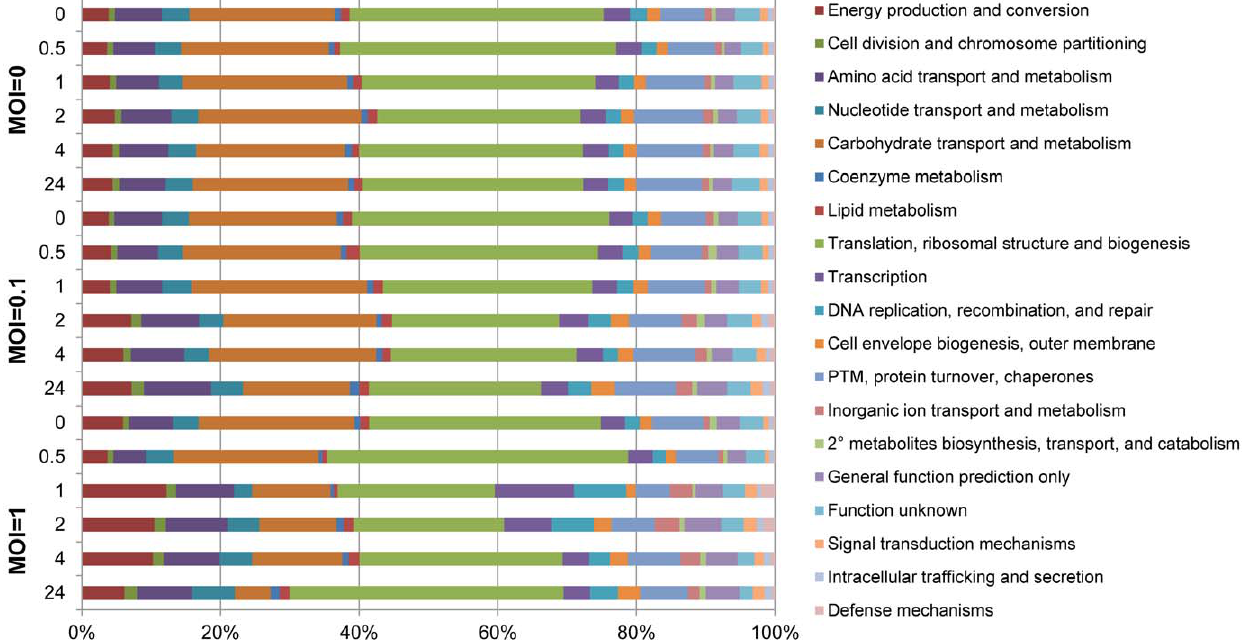
time point by their COG (clusters of orthologous groups) categories [33] (Figure 2). Host proteins encompassed the range of cellular functions from energy production and conversion to defense mechanisms, with the greatest percentage of proteins in